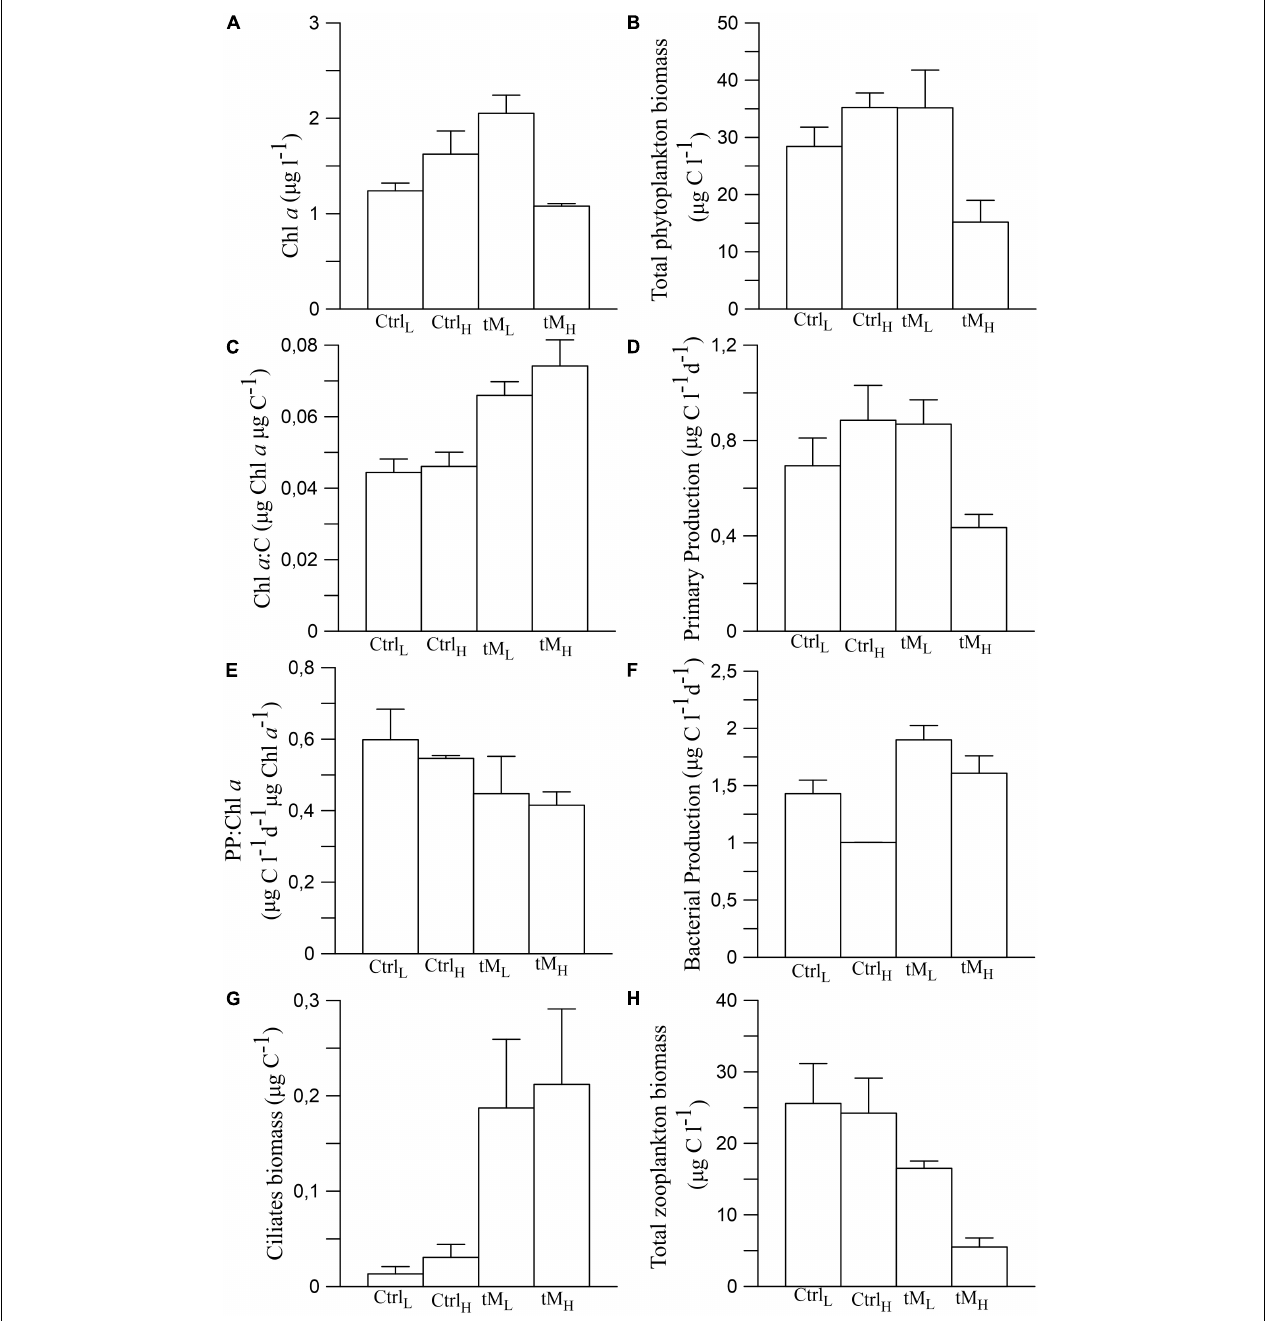
FIGURE 7 | Average Chl a (A) , total phytoplankton biomass (B) , Chl a :C (C) , primary production (D) , PP:Chl a (E) , bacterial production (F) , ciliate biomass (G) , and the zooplankton biomass (H) during the second part of the experiment (Day 17 and Day 28). Means ± standard error, n = 2.